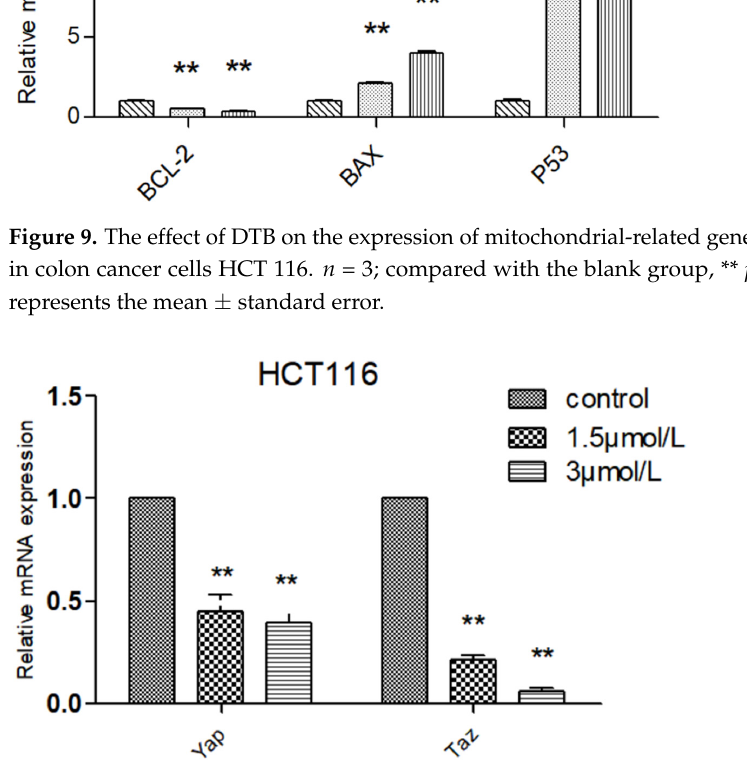
Figure 10. The effect of DTB on the expression of YAP and TAZ related genes of the HCT116 Hippo pathway in colon cancer cells. n = 3; compared with the blank group, ** p < 0.01, each data point represents the mean ± standard error.